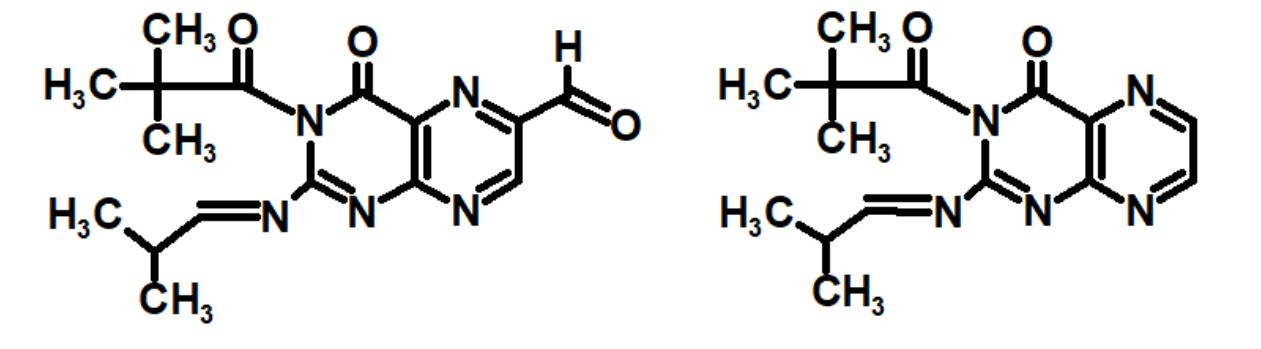
Figure 19. Synthetic pterins used for PDT [208].